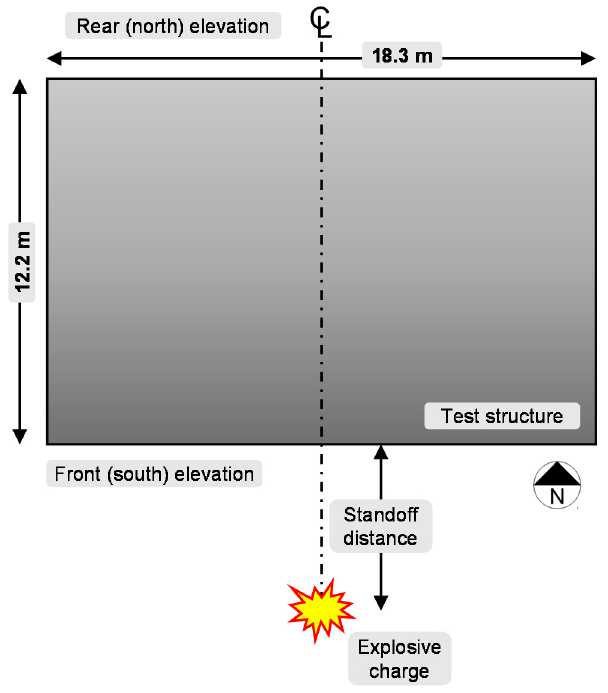
Figure 10. Overhead view of test configuration, which was the same for both tests.